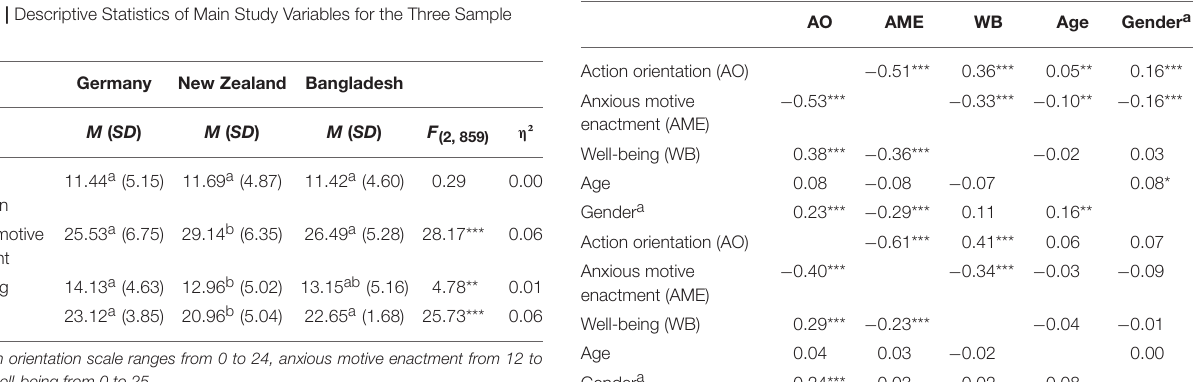
TABLE 2 | Correlations of the measured variables within the total sample (upper half: above the diagonal), the German sample (upper half: below the diagonal), the New Zealand sample (lower half: above the diagonal), and the Bangladeshi sample (lower half: below the